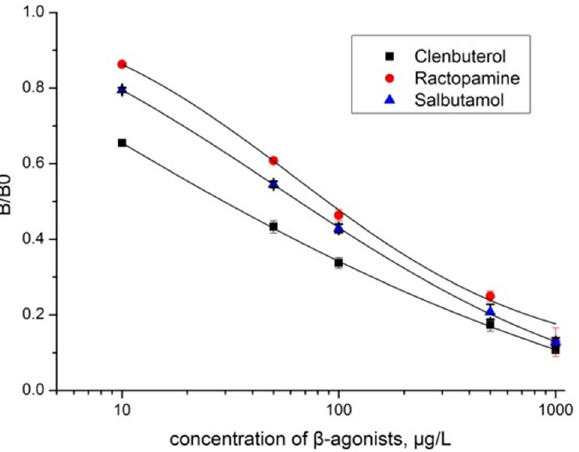
Fig 5. The calibration curves constructed by plotting the B/B0 ratio against the concentration of β - agonists. Each value represents the mean ± SD from 3 independent